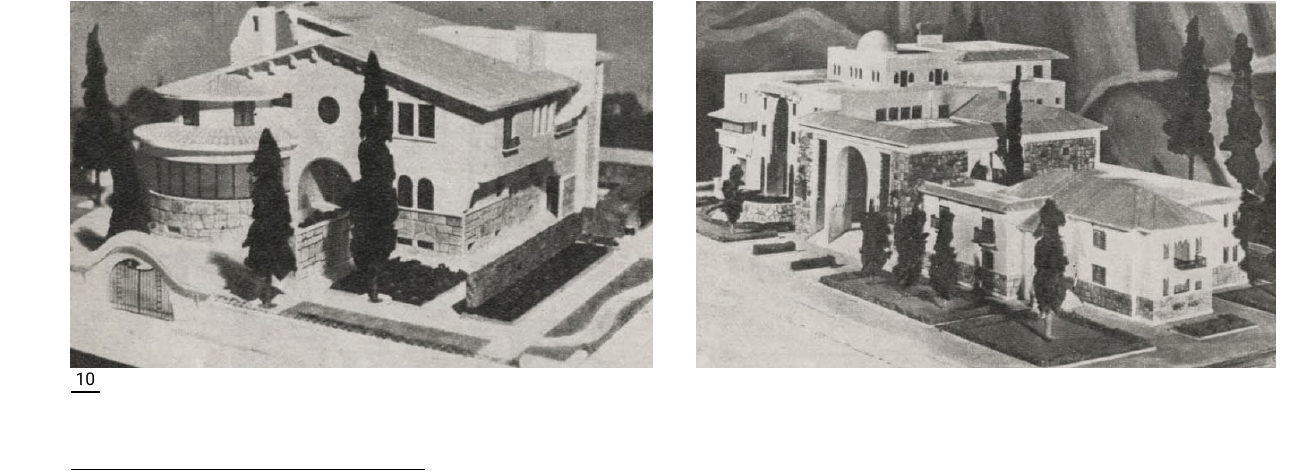
Two palace models designed by the Arabian Engineering Com- pany, an Egyptian Architecture firm, for the Saudi Royal